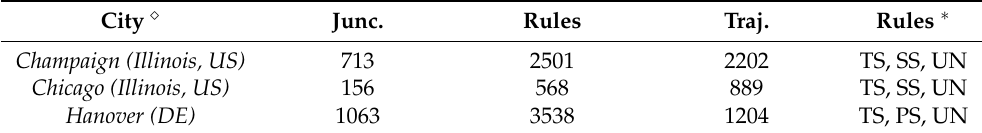
Table 1. Dataset used for testing the proposed